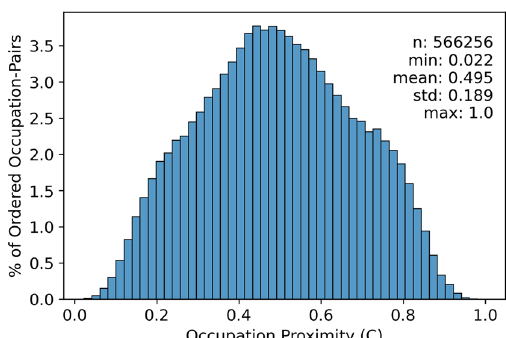
Fig. 1 Distribution of occupational proximities P S → T . The distribution is approximately symmetric with mean 0.45 and standard deviation 0.189. Note that each occupation pair will have two proximities = = depending on which is the starting occupation S and which is the target T